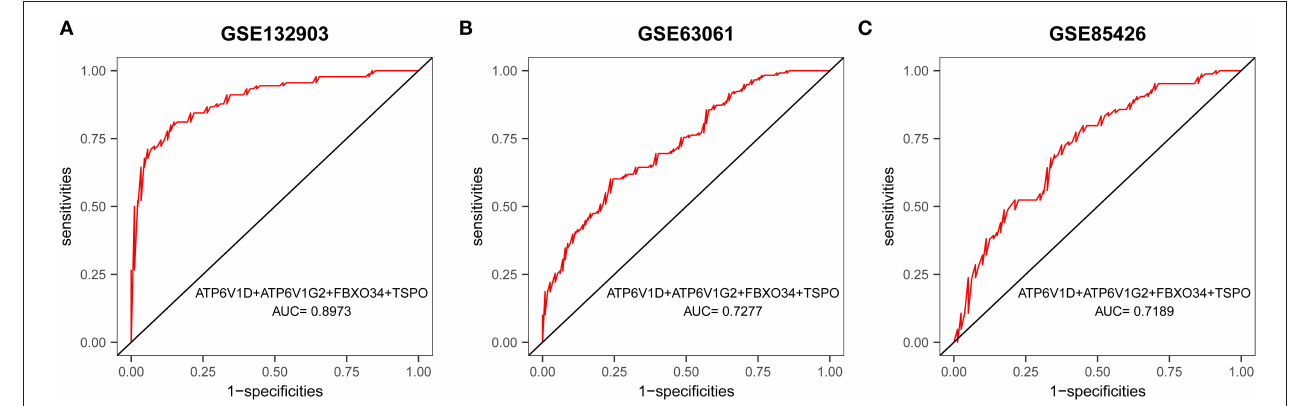
FIGURE 7 | ROC curves and corresponding AUC values for the three expression cohorts. (A) Brain tissue samples from GSE132903. (B) Blood samples from GSE63061. (C) Blood samples from GSE85426.